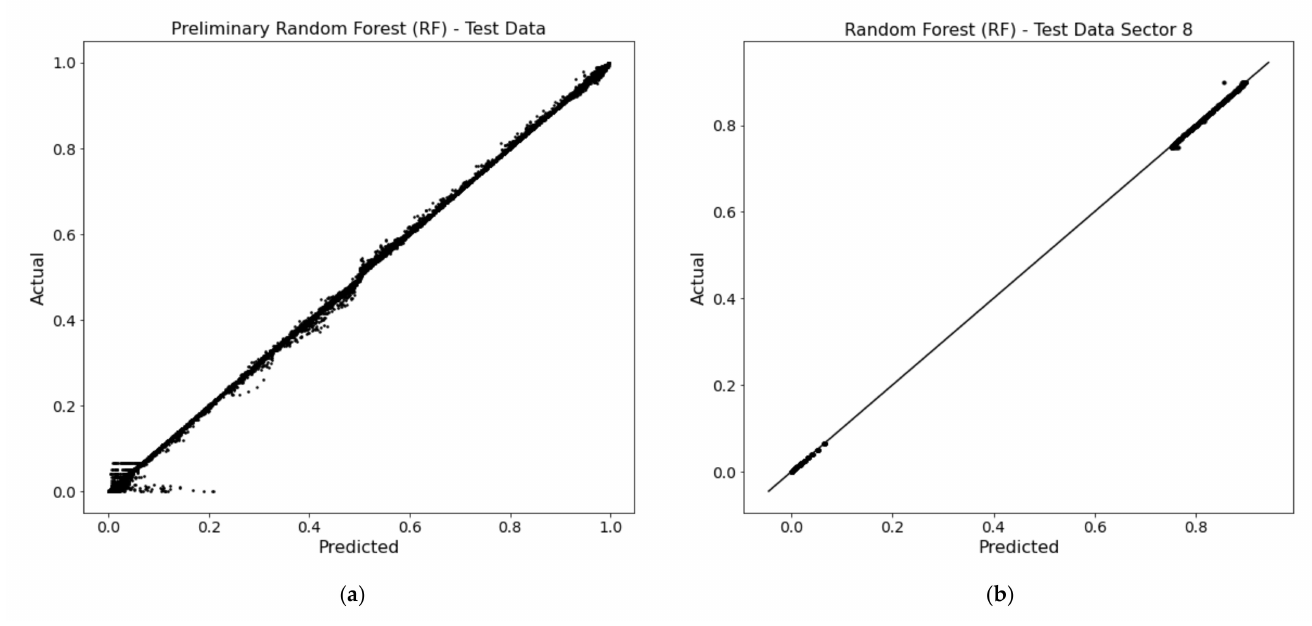
Figure 3. Random forest training results; ( a ) obtained for coarse estimation involving all input data; ( b ) obtained for accurate localization involving the Sector 8 input